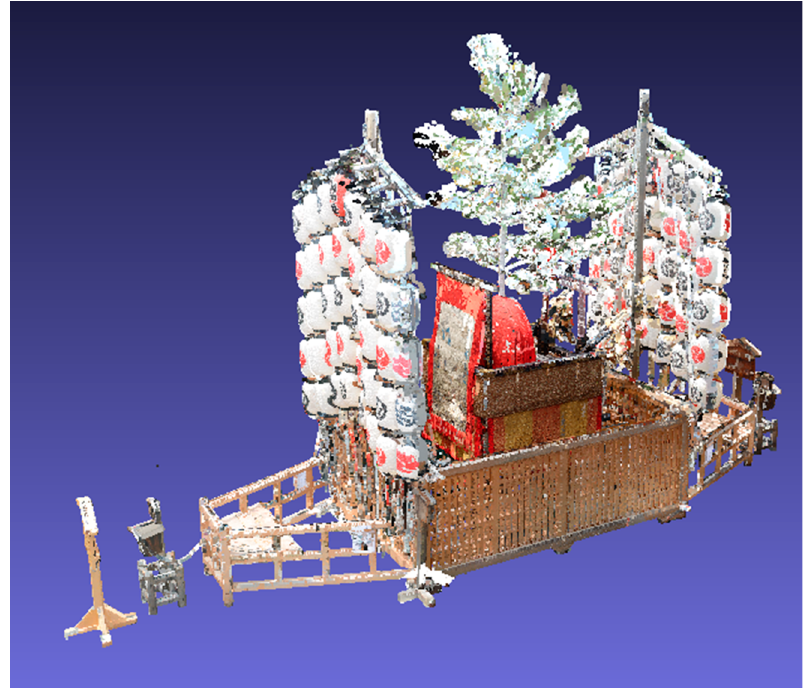
Figure A2. Laser-scanned point cloud of the Hachiman-Yama float (2.62 × 10 7 points).